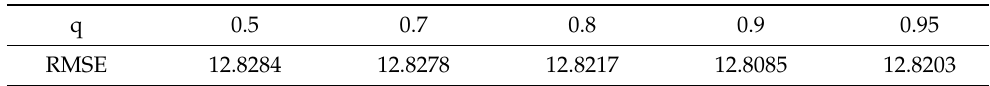
Table 5. Comparison of the RMSE for different compensators. Without Compensator MLP T1FS GMDH w